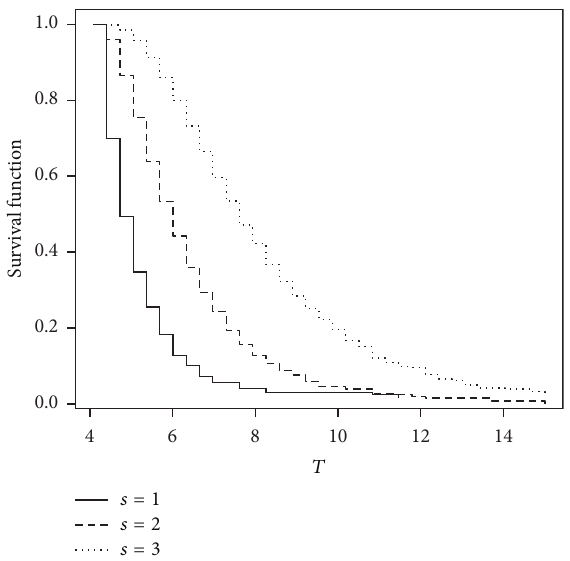
Figure 6: One-sample predictive survival function for real data set when 𝑟 = 20 .